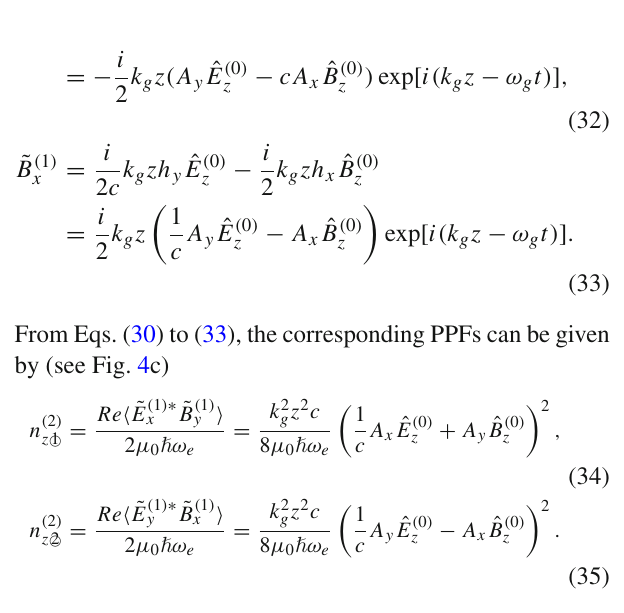
Fig. 4 Similar to Fig. 3, here: a n ( 2 ) , Eq. (26), caused only by ⊗ - z 1 (cid:9) ( 2 ) polarization HFGWs; n , Eq. (27), caused by ⊕ -, b - and l -polarization z 2 (cid:9) ( 2 ) HFGWs. b n , Eq. (28),caused by ⊕ - and the l -polarization HFGWs; z 1 (cid:9)